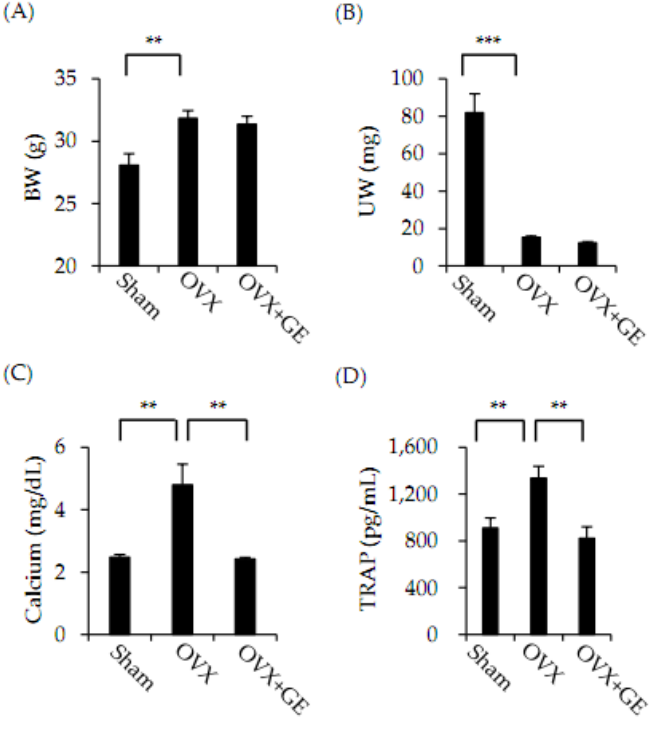
Figure 3. Effect of GE on body weight, uterus weight, and serum biochemical marker levels in ovariectomized (OVX) mice. Mice were treated with vehicle (DW) and GE (100 mg/kg/day) for 6 weeks. ( A ) Body weight (BW) and ( B ) uterus weight (UW). ( C ) Calcium and ( D ) TRAP were analyzed by using ELISA kits as described in materials and methods. Results are presented as means ± standard deviation (SD) ( n = 6). ** p < 0.01; *** p < 0.001 .